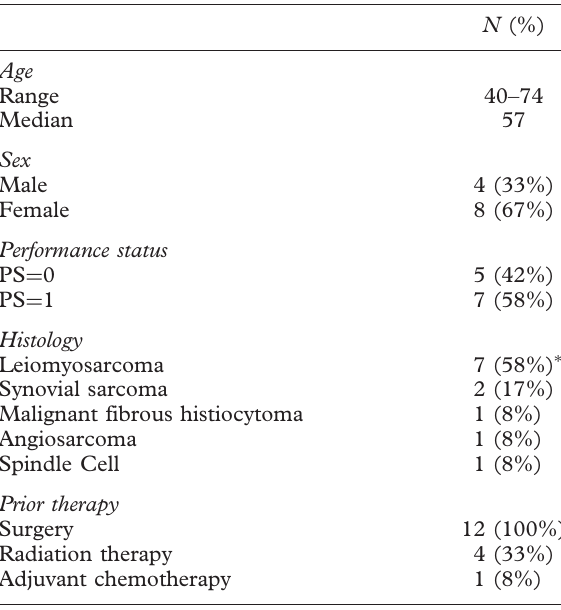
Table 1. Patient